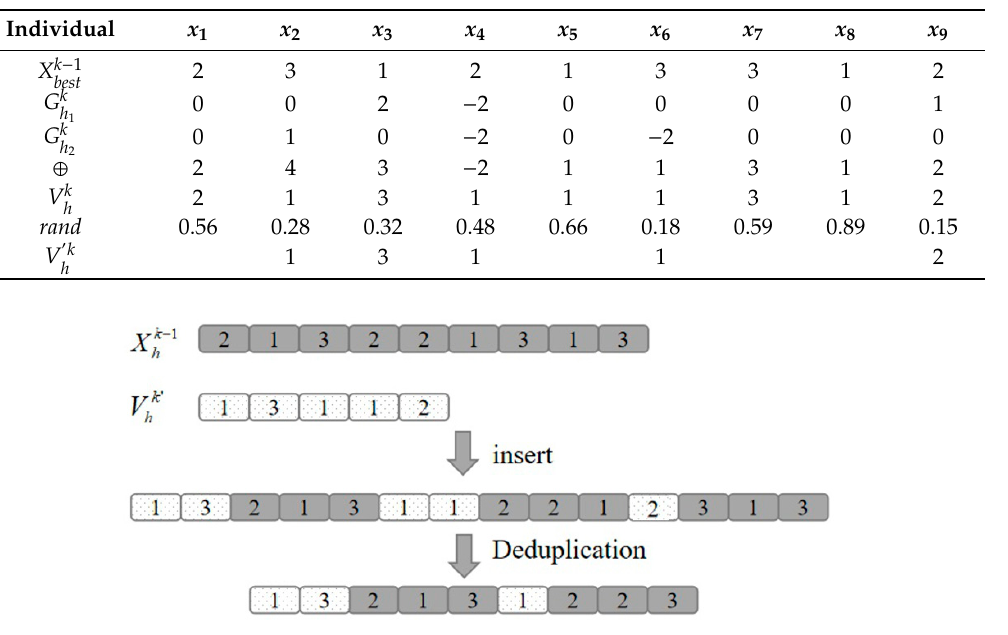
Figure 3. Diagram of crossover operation.